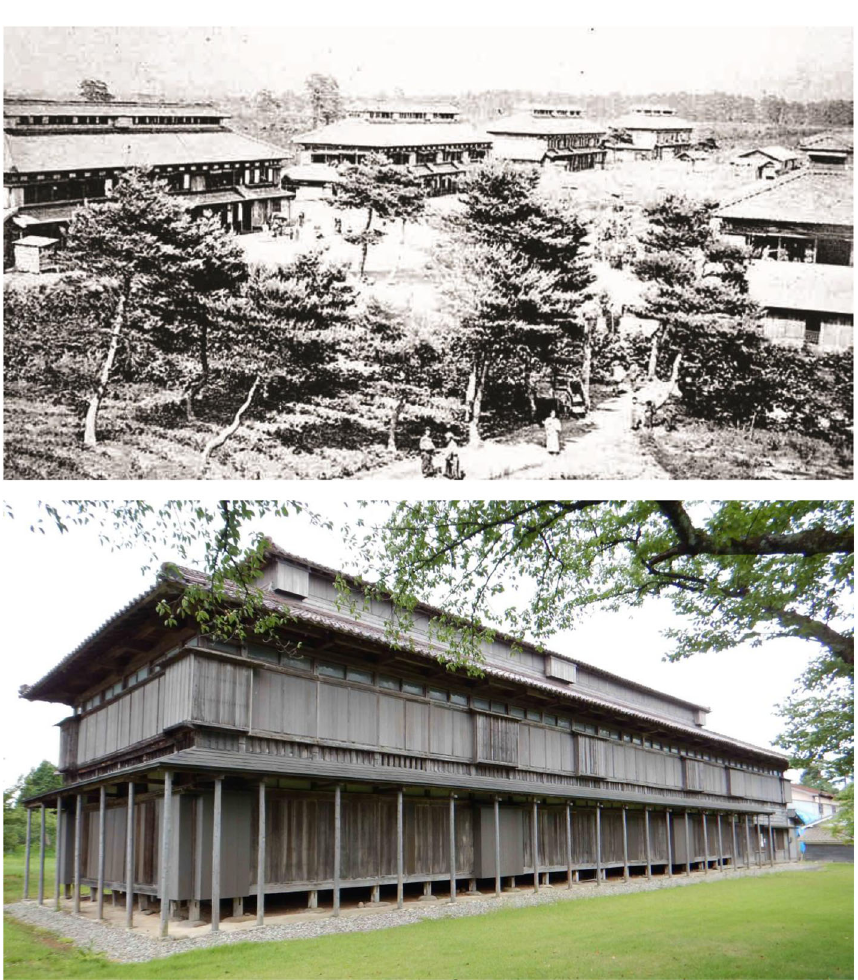
Fig. 3 Sericulture buildings at Matsugaoka Reclamation Land in Tsuruoka City, Yamagata Prefecture. Above: in the Meiji period (Source: Agency for Cultural Affairs 2013). Below: in the present (Source: Satoshi